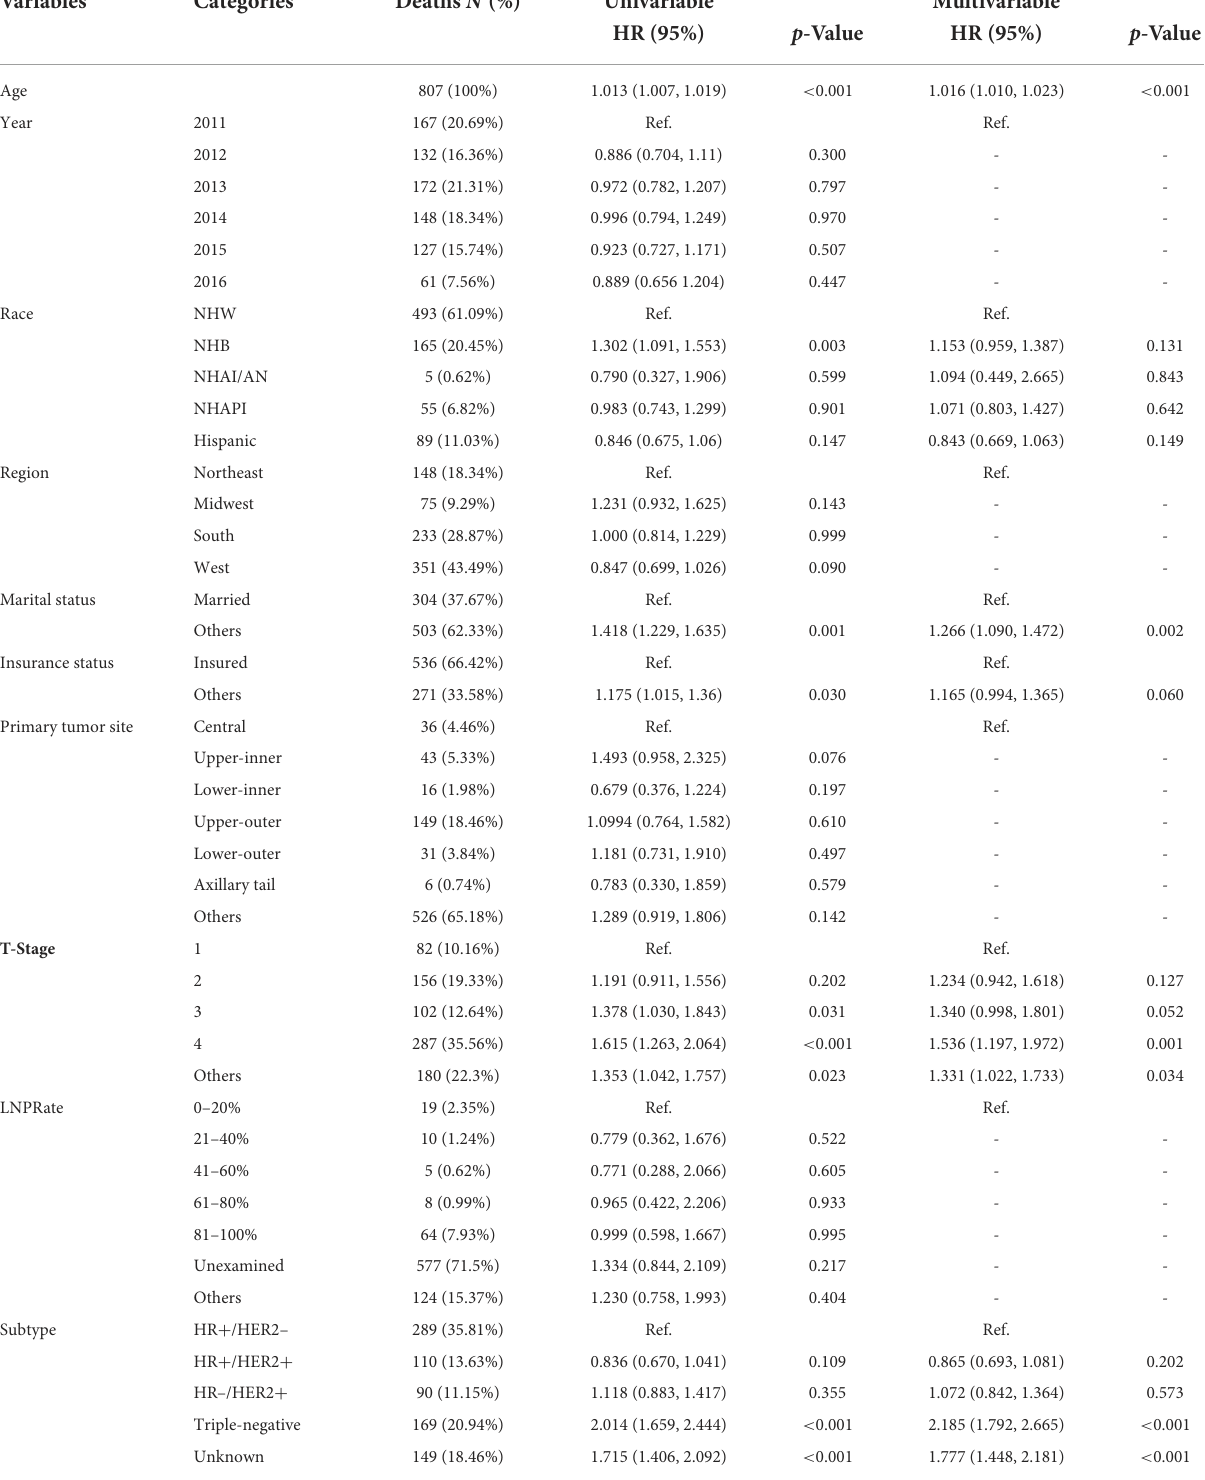
TABLE 4 Distribution of breast cancer synchronous brain metastases cancer-specific mortality and hazard risk associated with various prognostic